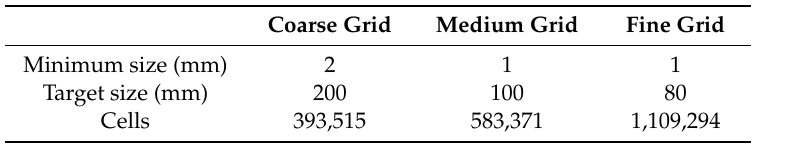
Table 2. Information for the grid sensitivity analysis.